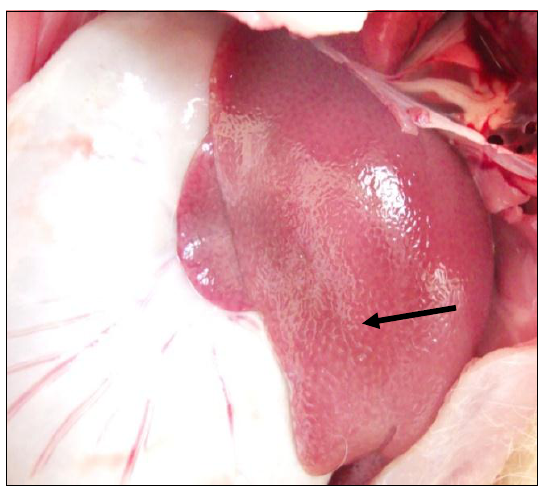
Fig:1 Gross rabbit lung of 1 st immunized group at 20days post challenge show slight congestion with some consolidating foci